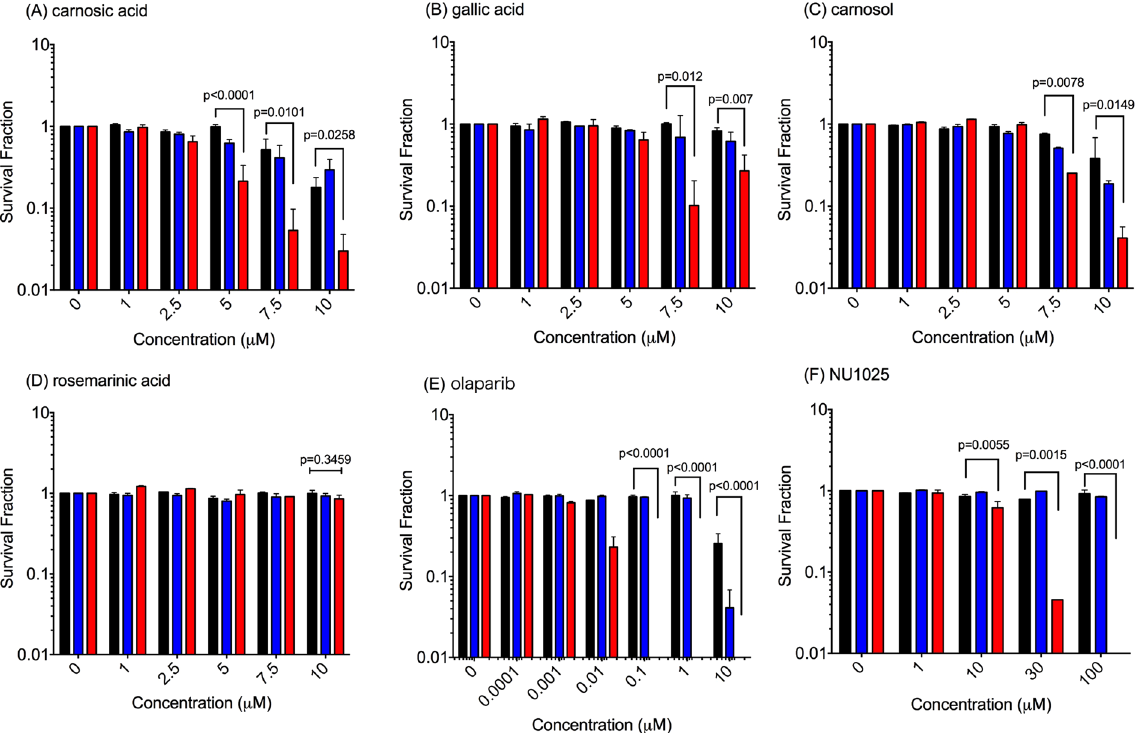
Figure 5. Cell survival curves against chemicals. ( A ) Carnosic acid ( B ) Gallic acid ( C ) Carnosol ( D ) Rosmarinic acid ( E ) Olaparib, ( F ) NU1025. Black bars indicate V79, blue bars indicate gene corrected V-C8, and red bars indicate V-C8 cells. At least three independent experiments were carried out. Error bars indicate standard error of the mean. P-values represent two-way ANOVA analysis between V79 and V-C8. P-values smaller than 0.05 were considered to be statistical